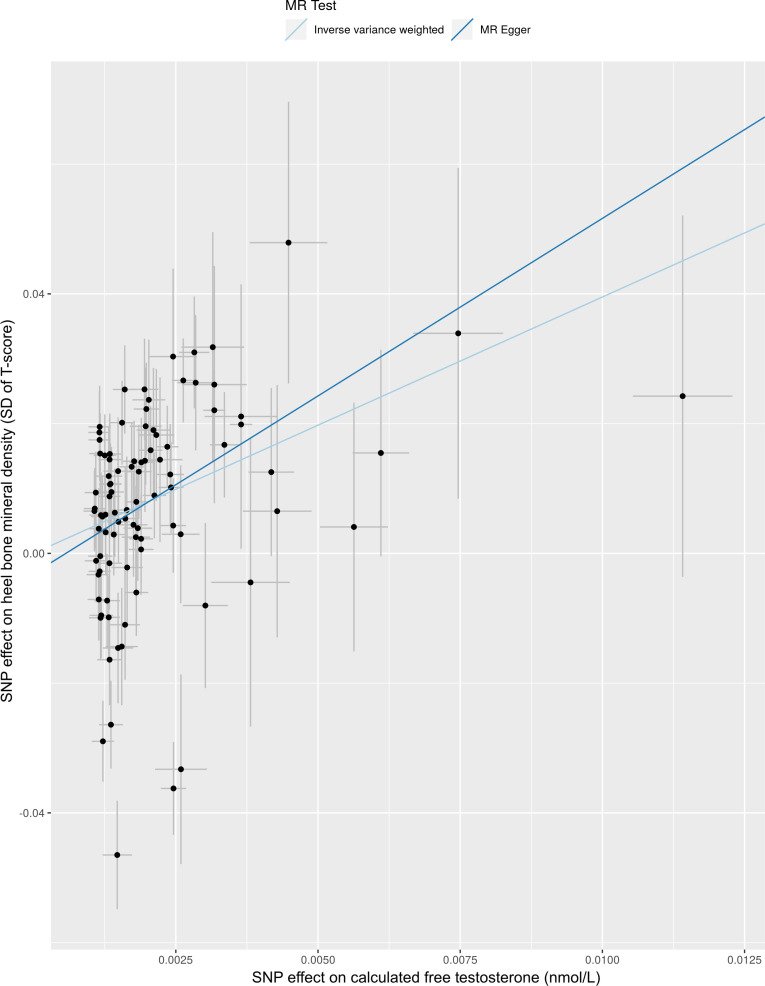
Comparison of effect of calculated free testosterone on heel bone mineral density using Mendelian randomization with IVW and Egger regression methods.